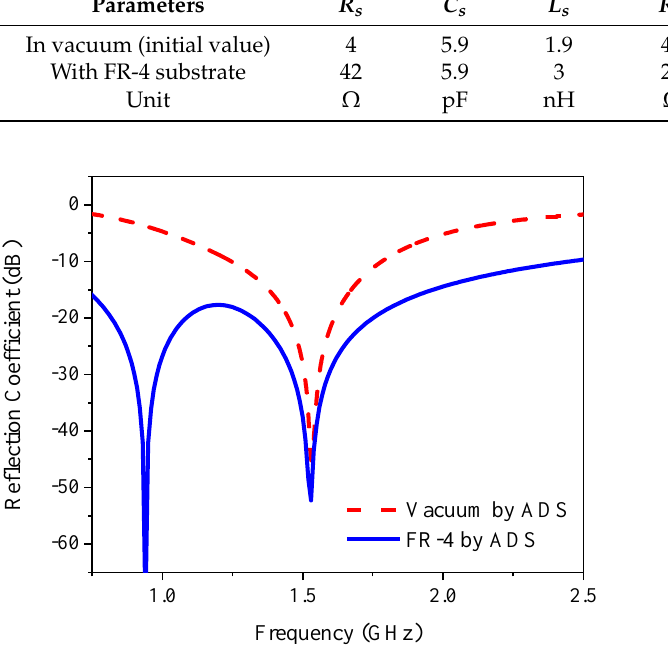
Figure 6. Simulated reflection coefficient of equivalent circuit of inverted L-shaped planar monopole antenna on a partial ground plane in vacuum and with FR-4 substrate.